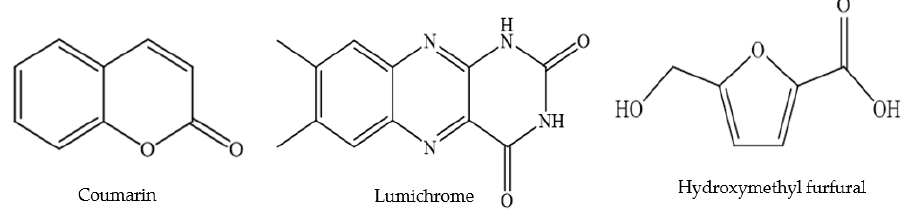
Figure 9. Miscellaneous compounds.